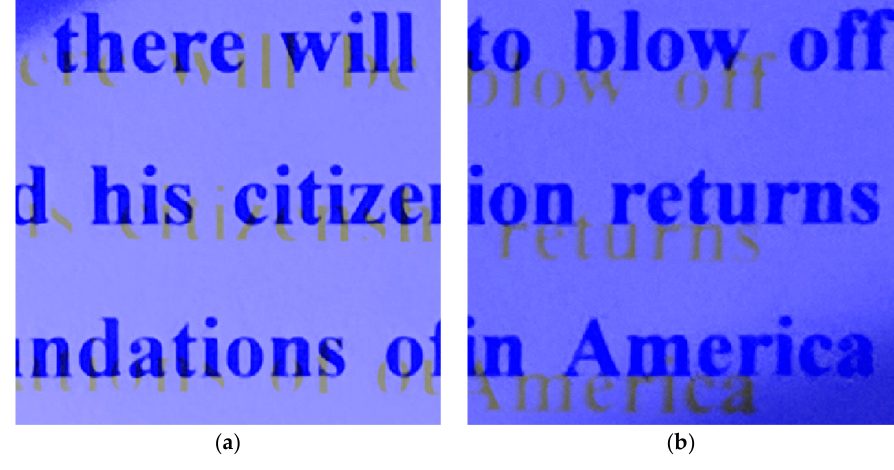
Figure 4. Pseudo color image composed of Figure 1a,c. The green and blue bands come from the green and blue bands of Figure 1b, while the red band is from the red band of Figure 1c. ( a ) The small image patch from the bottom-left part of the pseudo color image. ( b ) The small image patch from the bottom-right part of the pseudo color image.